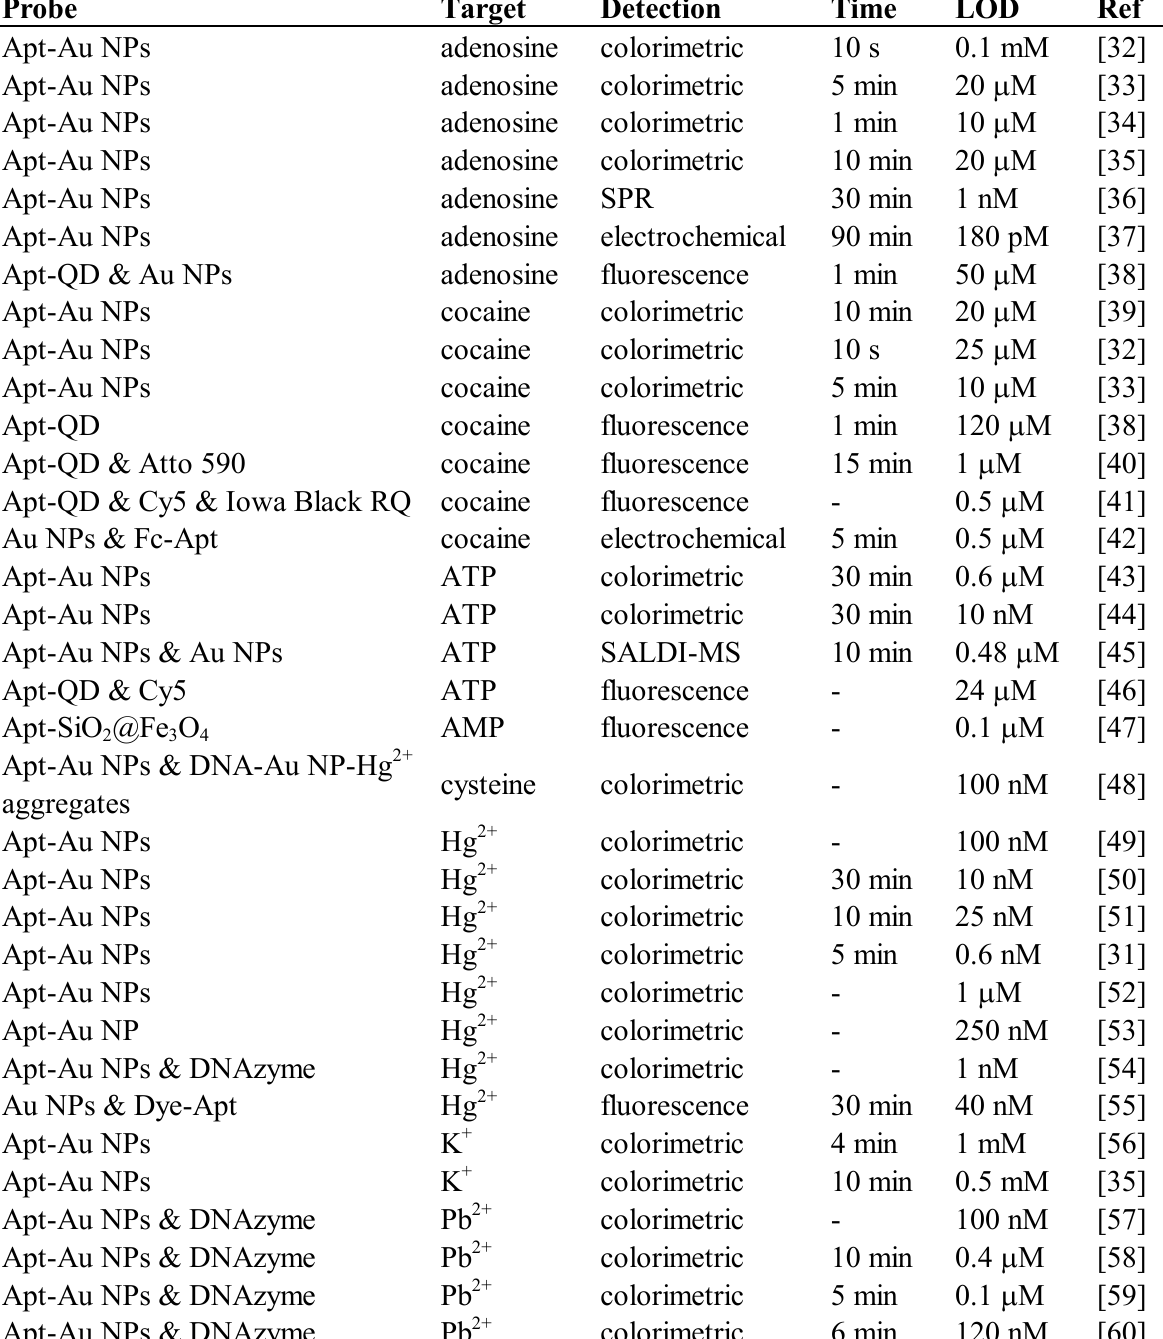
Table 1. Representative aptamers used for the detection of small